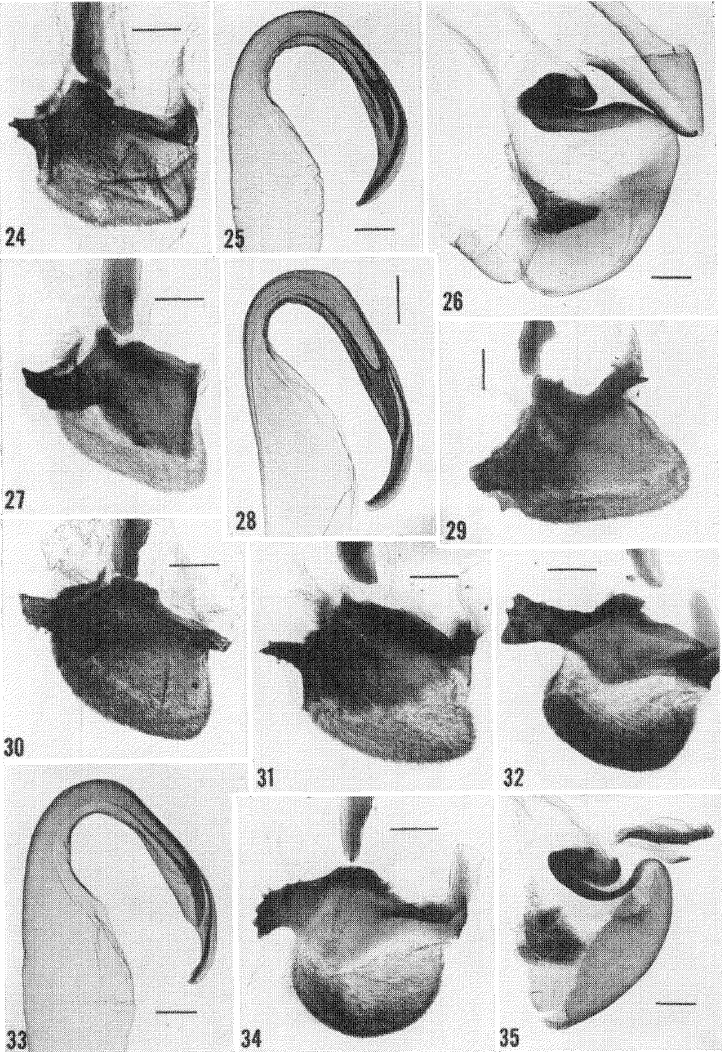
Figs. 24-35. Cockroach male genitalia. Epilampra conferta. 24-26. (134 USNM). E1 Valle, Panama (det. Princis). 27-28. (136 USNM). Barro Colorado Island, Panama. (det. Princis). 29. (135 USNM). Barro Colorado Island, Panama. (det. Roth). 30. (50 ANSP). Chiriqui, Panama. (labeled stigmosa in pencil). 31. (105 USNM). San Isidrodel, General Cattago, Costa Riea (det. Prineis). 32-33. (132 USNM). Napo, Santa Cecilia, Rio Aguarieo, Ecuador. (det. Roth). 34-35. (133 USNM). Same locality as 32-33. (det. Roth). (scale 0.2